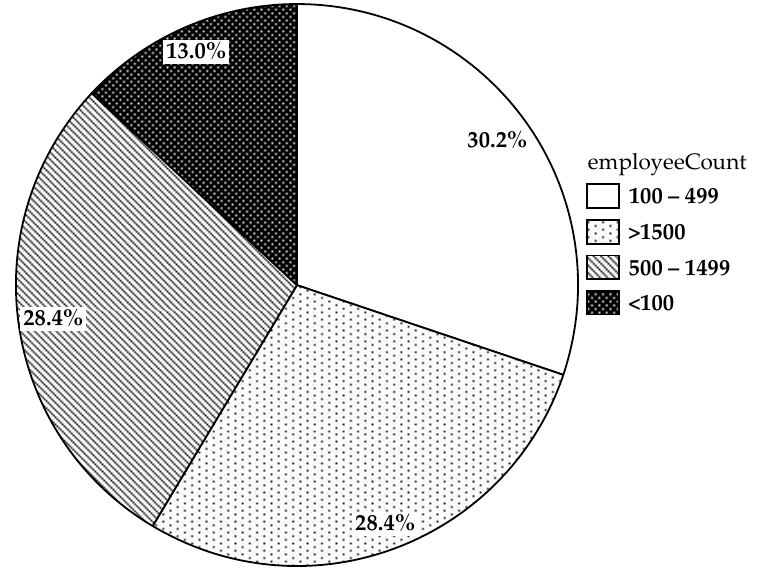
Figure 3. Number of employees .